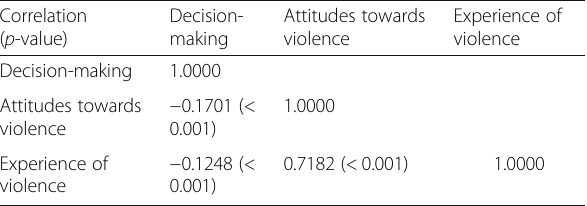
Table 5 Correlation between Main Exposure Variables Correlation ( p -value)